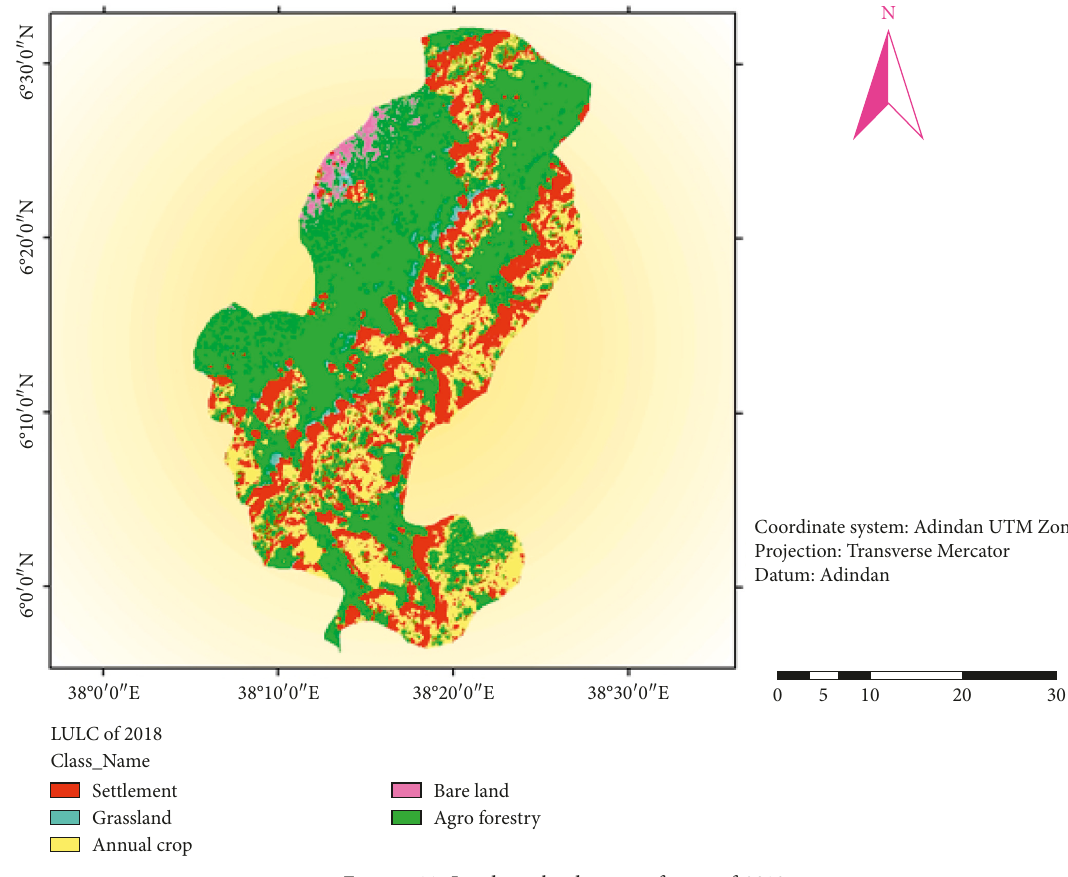
Figure 11: Land use land cover of map of 2018. Table 3: Summary of LULC of Gedeo zone during 1988–2018 by 10 years